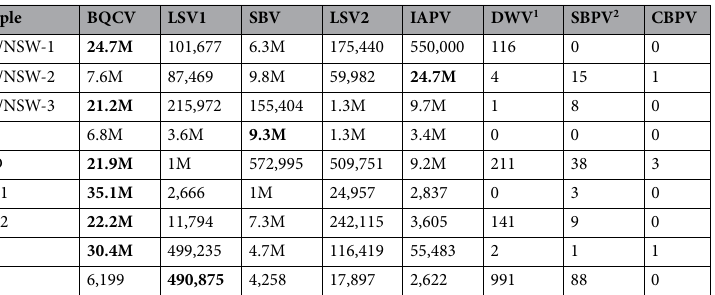
Table 2. Normalised reads of honeybee viruses detected from Region 1 to 4 defined in Fig. 1 with the most prevalent virus in each region in bold. Reads for DWV and SBPV strains are mapped with a similarity threshold of 0.7 and all other viruses are mapped with a similarity threshold of 0.9. 1 virus complex including